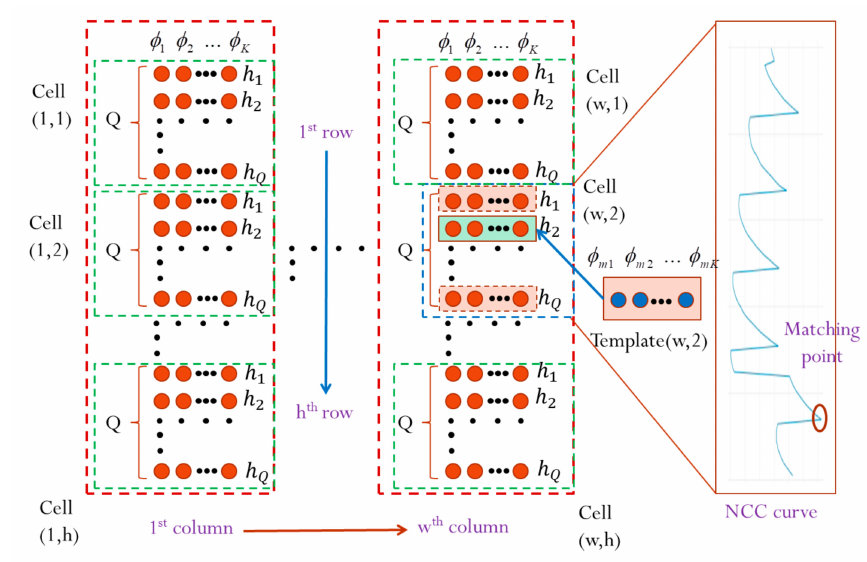
Figure 6. Illustration of the proposed absolute height calibration algorithm with every image pixel.